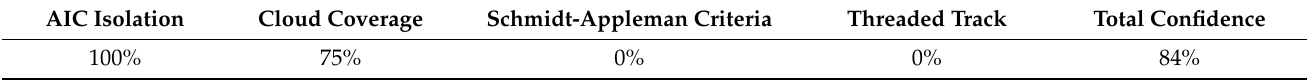
Table 3. Confidence index for the case study.